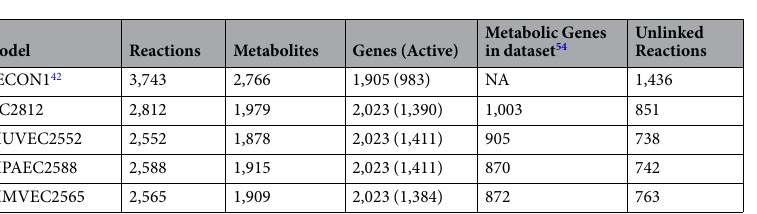
Figure 2. The structure, components and differences in metabolism of iEC2812 and comparison of the endothelial subtype genome scale metabolic models iHUVEC2552, iHPAEC2588 and iHMVEC2565. ( a ) The distribution of reactions in RECON1 (inner circle) and iEC2812 (outer circle) divided into metabolic super subsystems. ( b ) The majority of essential genes are shared between each sub-type model, iHUVEC2552 and iHPAEC2588 overlap totally and iHMVEC2565 has one unique essential reaction. ( c ) The classifications of essential reactions by subsystem . Alanine/aspartatane, eicosanoids, exchange, glycerophosphlipid, miscellaneous, nucleotide, purine, sphingolipid, extracellular transport and nuclear transport .